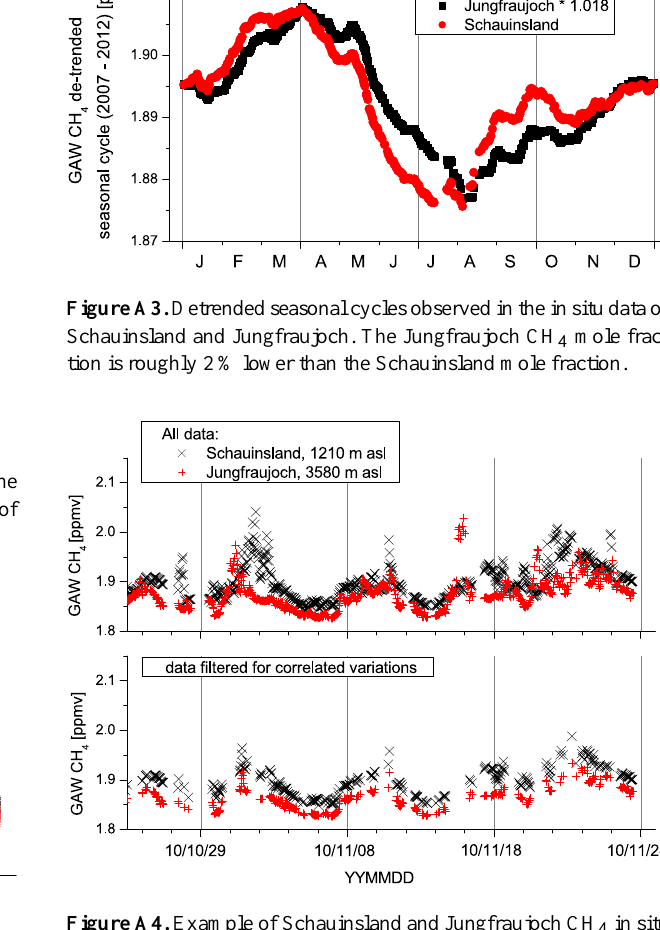
Figure A2. Overview of the coincident Schauinsland and Jungfrau- joch in situ CH 4 time series.